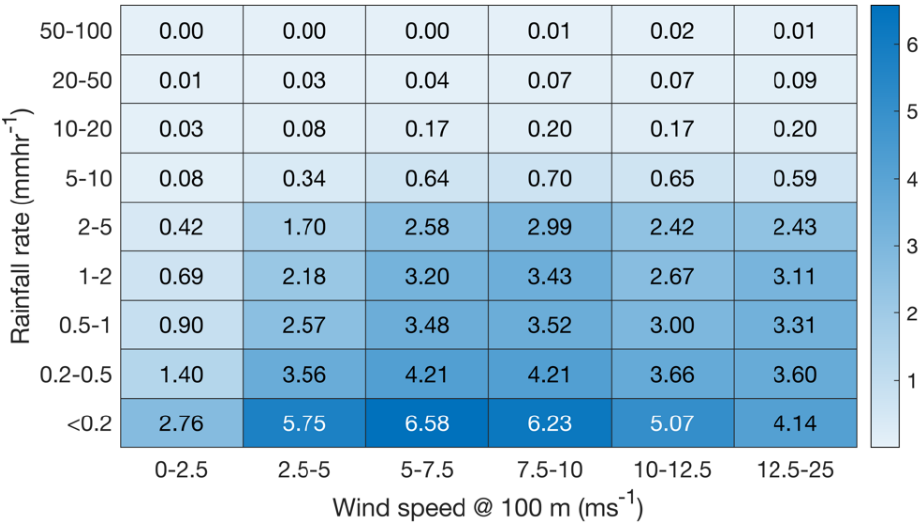
Figure 13. Heatmaps of the joint probabilities (in %, colorbar and also numeric values shown in each cell) of RR and wind speeds at onshore Denmark. The joint probabilities are computed for periods with liquid precipitation.